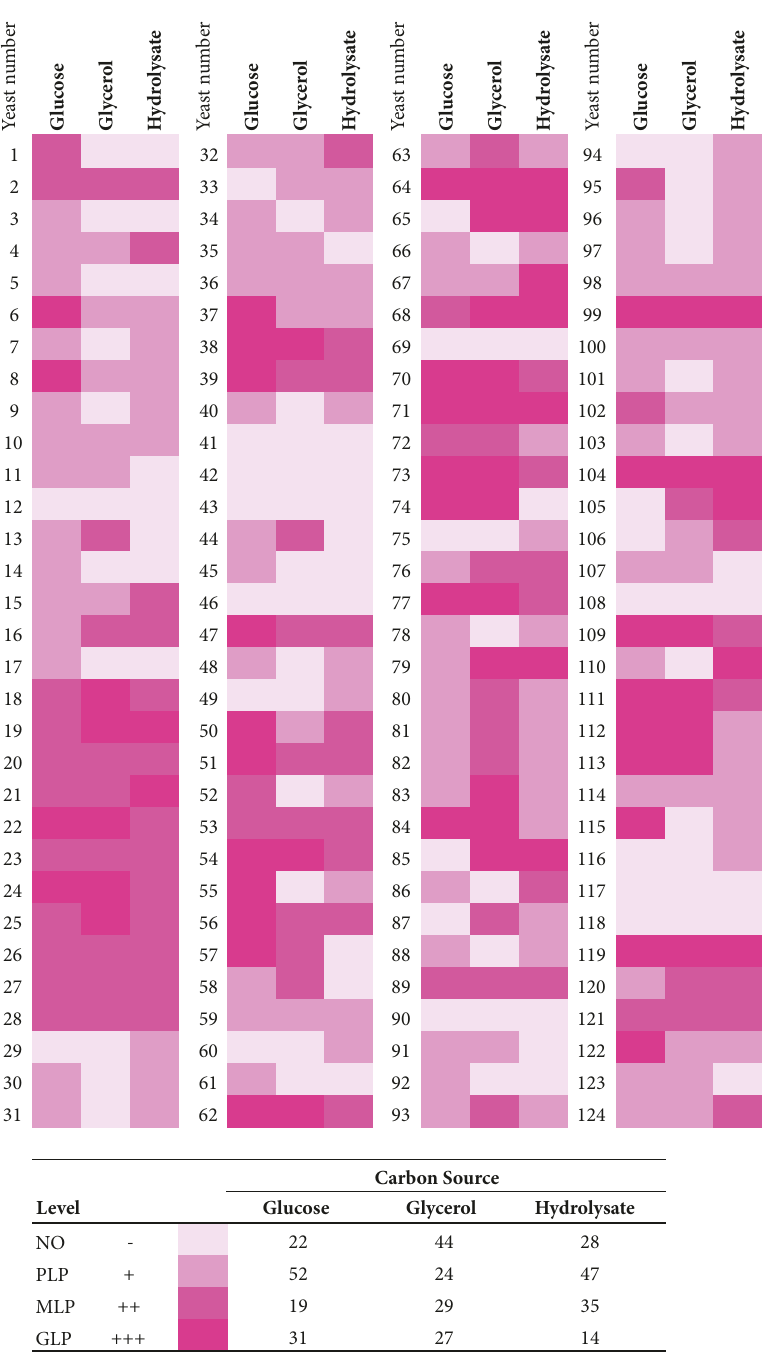
Figure 5: Screening of oleaginous white yeasts on different carbon sources: glucose, glycerol, and lignocellulosic hydrolysate. The yeasts were classified as follows: GLP, good lipid producer; MLP, moderate lipid producer; PLP, poor lipid producer; and NO, non-oleaginous. A total of 372 (124 × 3) plates (size 35 × 10 mm) were used in this